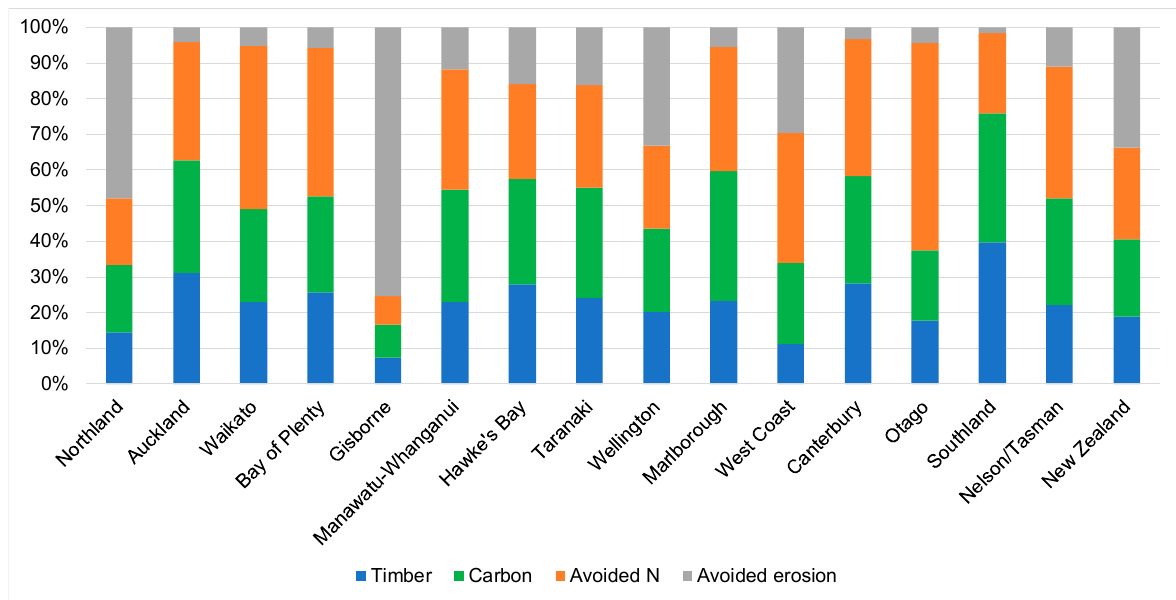
Figure 4. Stacking up selected ecosystem services of planted forests by NZ region and for whole of NZ.